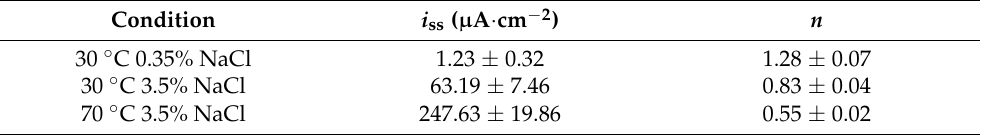
Table 1. Stable state current density i ss and passivation parameter n for Fe-based amorphous coating samples in the NaCl solution with various concentration and